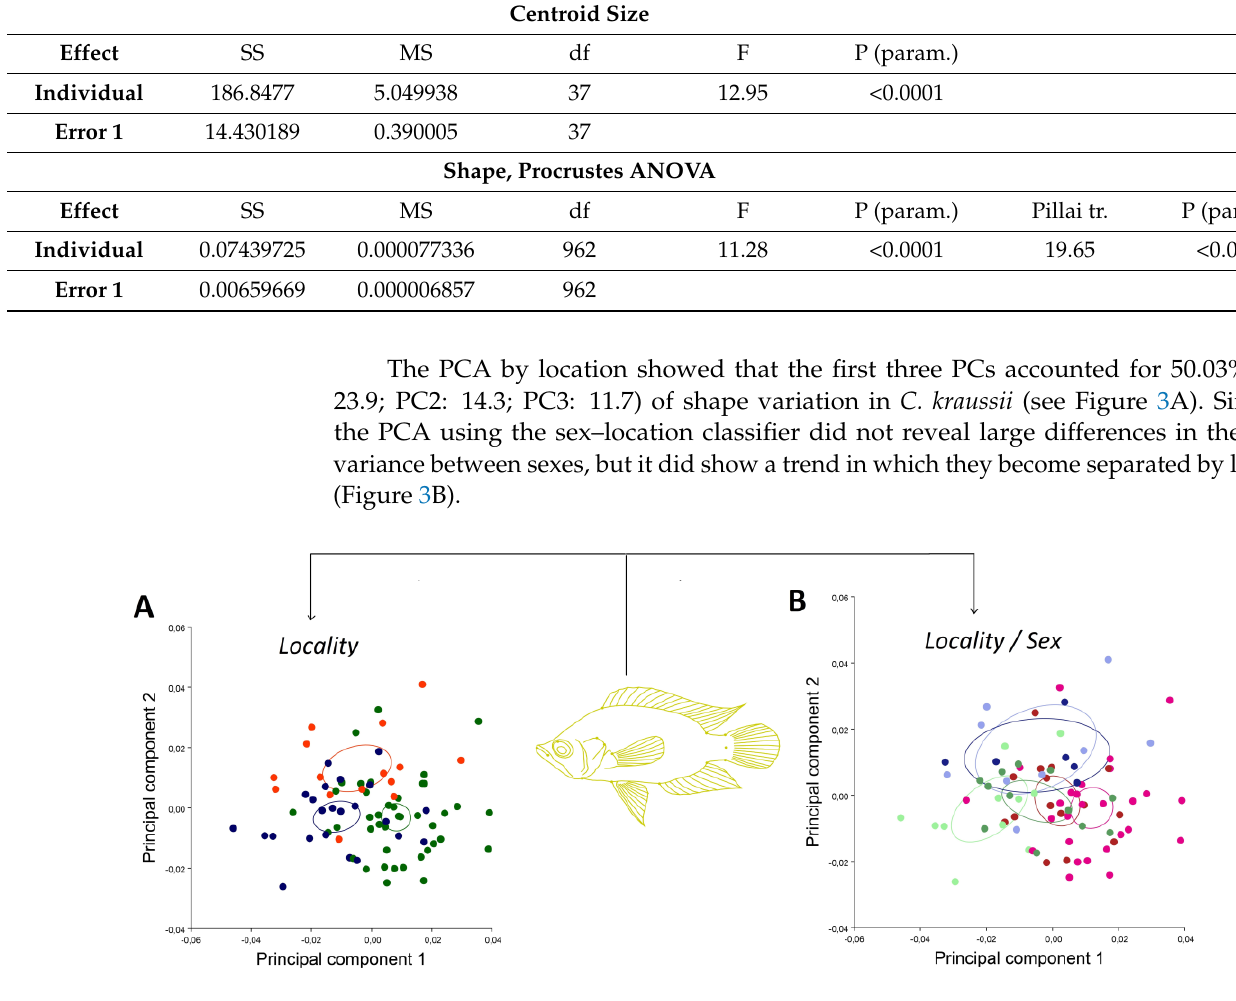
Figure 3. Principal component analysis of Caquetaia kraussi: ( A ): scatterplot of shape variation between three localities. Green: UEP1; orange: UEP4; and blue: UEP2. ( B ): Scatterplot of intralocality sexual shape dimorphism between three localities. Pink: female UEP1; red: male UEP1; light green: female UEP2; dark green: male UEP2; light blue: female UEP4; and dark blue: male UEP4. The confidence ellipses were computed from the mean shape using the criteria locality and